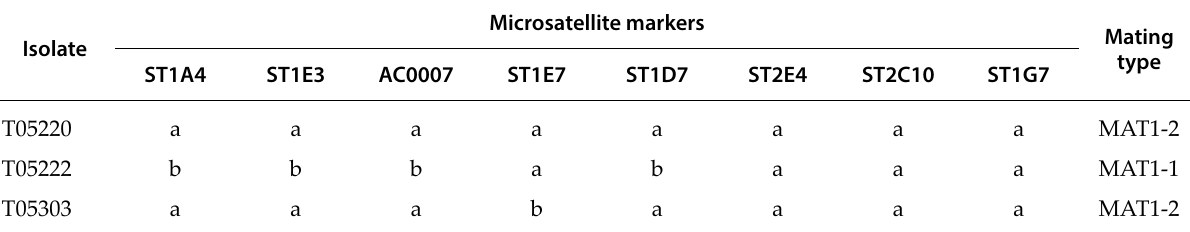
Table 2. Genetic fingerprinting of the three QoI-resistant Algerian isolates of Zymoseptoria tritici with eight microsatellite markers, with their identified mating types. Each letter indicates the allele obtained for each isolate with the correspond - ing marker. Microsatellite markers Isolate